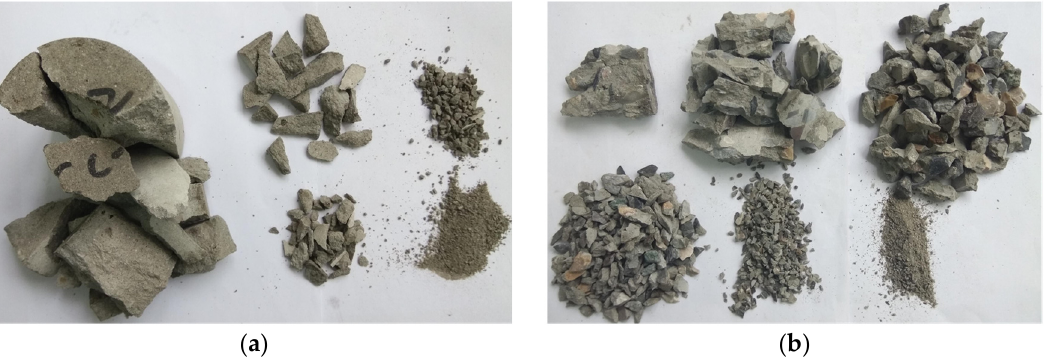
Figure 11. Fragmentation morphologies of mortar and concrete: ( a ) Mortar (466.29/s), ( b ) Concrete (480.78/s).